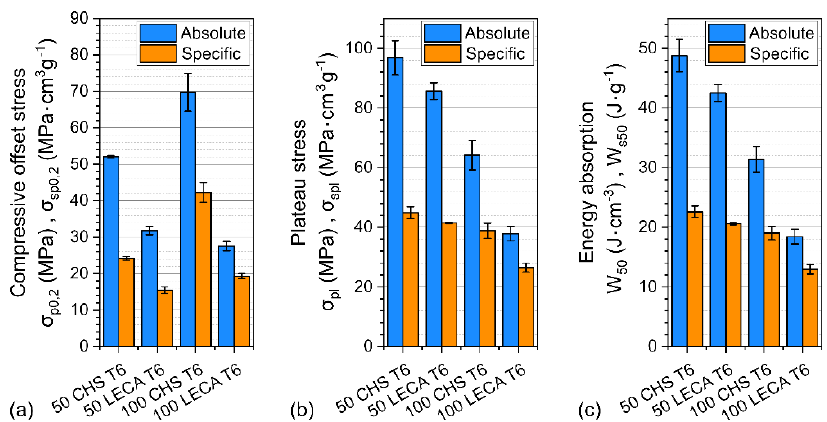
Figure 7. The compressive offset stress ( a ), plateau stress ( b ), and energy absorption ( c ) values of the tested samples.